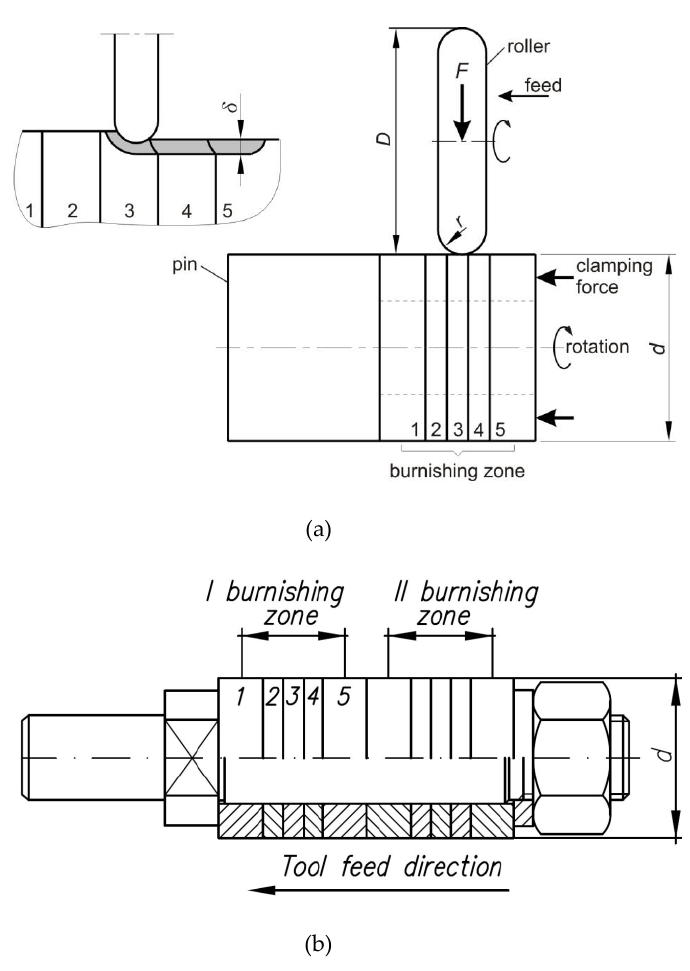
Figure 4. Schematic diagram of ( a ) the test method and ( b ) mandrel with mounted rings: 1, 5 – stopper rings; 2, 3, 4 – operating rings.